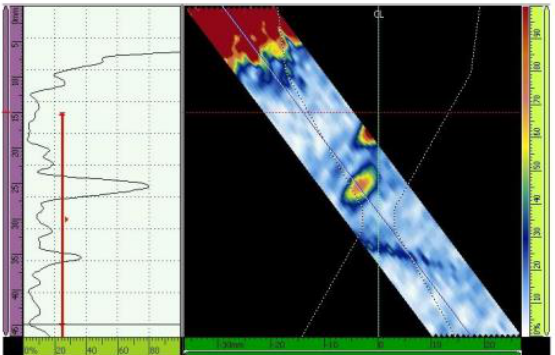
Figure 13. Echo (maximized to 80% of the screen height) from the third hole. Scanning angle of 45° and 16 active elements. Primary gain = 50 dB.